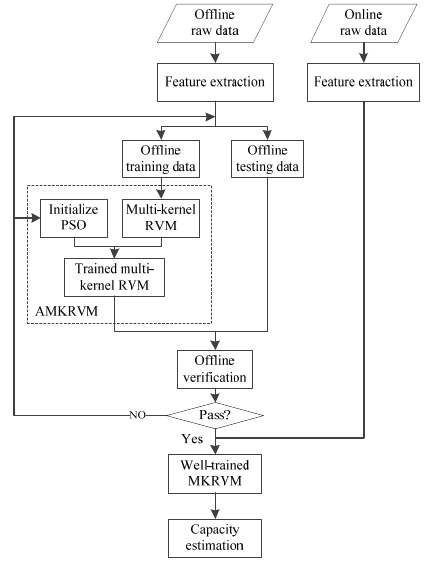
Figure 4. Overall procedure for capacity estimation.